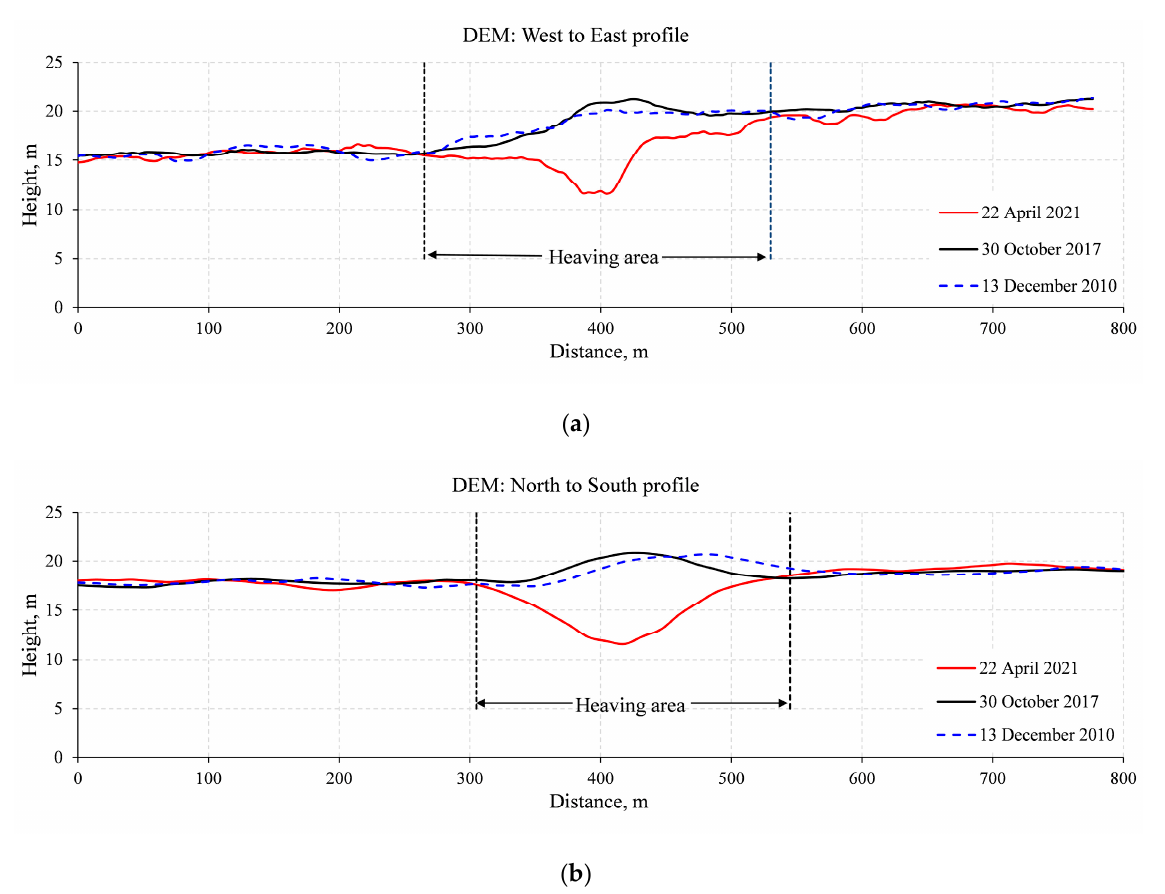
Figure 5. Comparison of multi-temporal TerraSAR-X/TanDEM-X DEMs. Elevation along profiles crossing the mound/crater from ( a ) west to east and ( b ) from north to south.